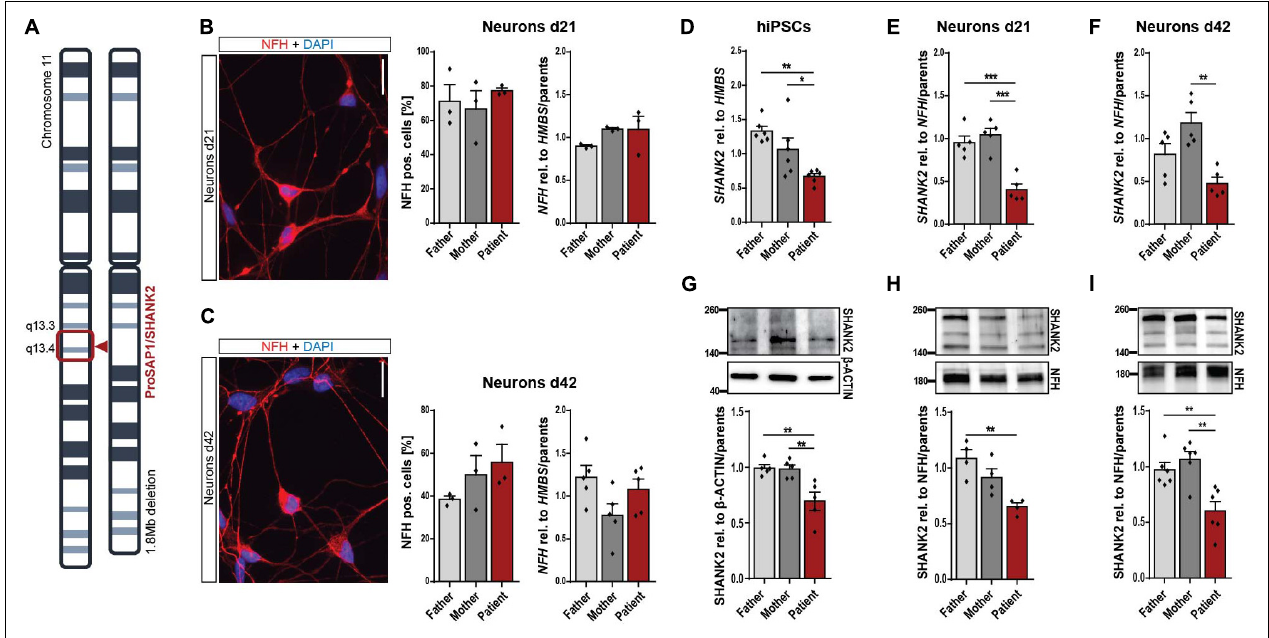
FIGURE 1 | Neuronal differentiation and reduction of SHANK2 expression in hiPSCs and derived neurons. (A) Chromosomal deletion of the patient with SHANK2 deletion. (B,C) Neurons d21 (B) and d42 (C) stained for NFH and DAPI. Percentage of NFH-positive cells ( n = 3). NFH RNA levels in total cell lysate (d21 n = 3; d42 n = 5). (D) SHANK2 RNA relative to HMBS ( n = 6) in hiPSCs. (E) SHANK2 RNA relative to NFH ( n = 5) in neurons d21. (F) SHANK2 RNA relative to NFH ( n = 5) in neurons d42. (G) SHANK2 protein expression relative to β -ACTIN ( n = 5) in hiPSCs. (H) SHANK2 protein levels relative to NFH ( n = 4) in neurons d21. (I) SHANK2 protein levels relative to NFH ( n = 6) in neurons d42. NFH, neurofilament heavy chain; HMBS, hydroxymethylbilane synthase. Scale bar = 20 µ m. Data were normalized to mean of parents if indicated. Mean ± SEM, one-way ANOVA, followed by Tukey’s post hoc analysis. Significance levels were set to * p ≤ 0.05, ** p ≤ 0.01, and *** p ≤